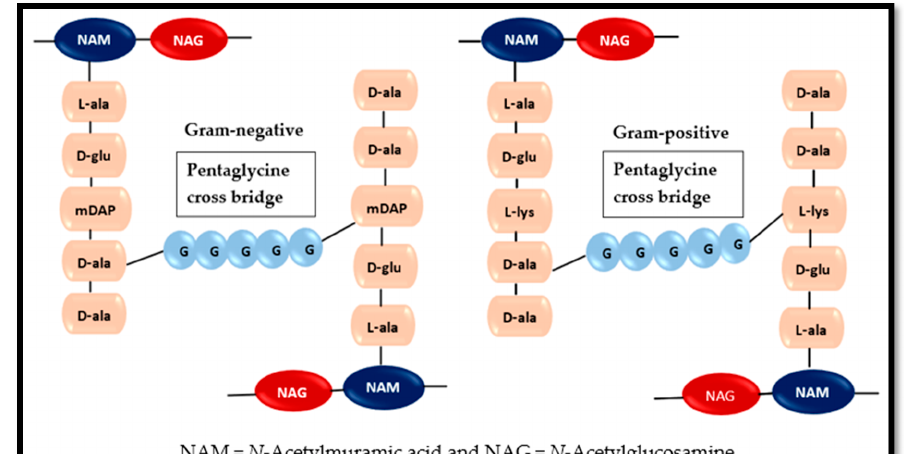
Figure 8. Pentaglycine cross ‐ linkages in Gram ‐ negative and Gram ‐ positive bacterial